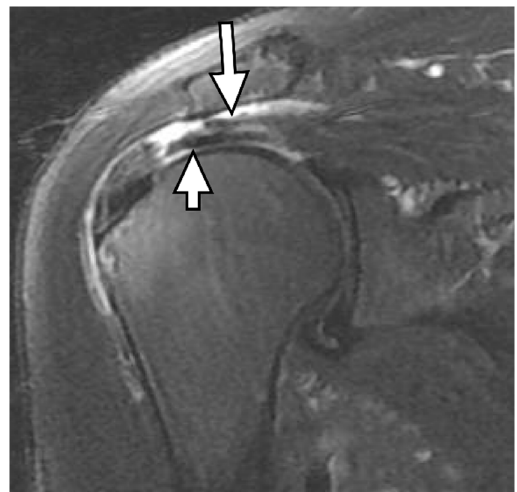
Figure 11. Bursal-delaminated full-thickness tear of the supraspinatus tendon. An oblique coronal fat-suppressed T2-weighted image of the supraspinatus tendon shows a bursal-delaminated full- thickness tear with a visible cleavage. The bursal surface (long arrow) is retracted more medially than the articular surface (short arrow).